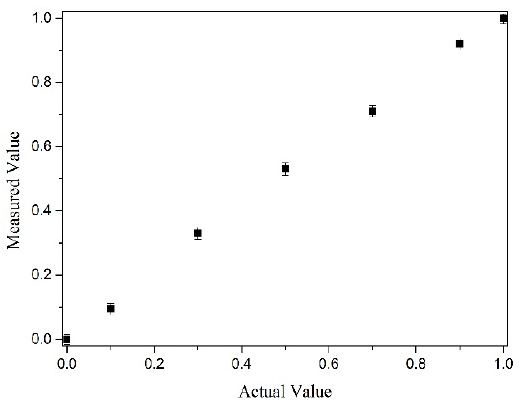
Figure 2. Comparison between the actual and measured values by the novel method.